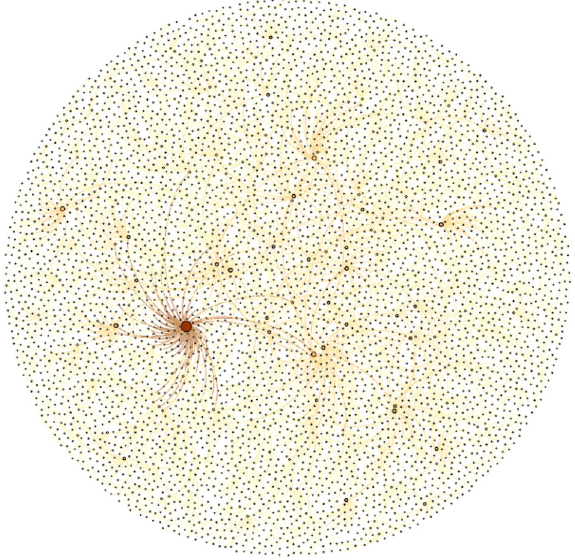
Fig. 2 Referrer-investor relationships as a social network. This graph illustrates the Ponzi scheme as a social network. The nodes are individual investors and the lines connecting them represent referrer-investor relationships. The largest node (in red) in the middle is the originator of the scheme. The graph includes all investors who can be linked to the originator through a chain of referrers.